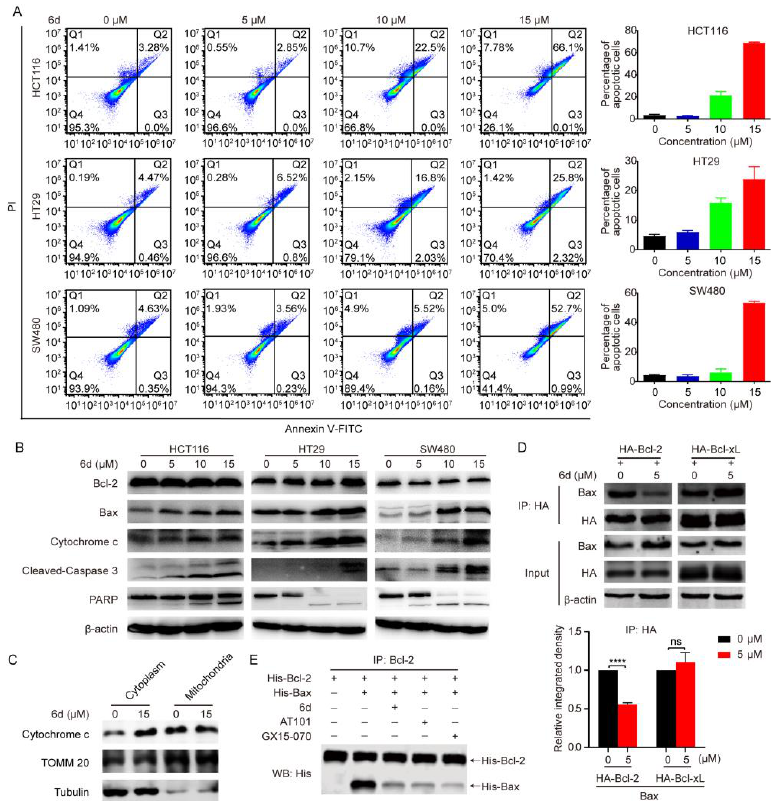
Figure 2. Compound 6d induces mitochondrial-mediated intrinsic apoptosis by targeting Bcl-2. ( A ) CRC cells were treated with indicated concentrations of compound 6d for 8 h and then stained with the Annexin V-FITC/PI kit. The stained cells were analyzed with flow cytometry analysis. ( B ) Compound 6d regulates the expression of apoptosis-related proteins. CRC cells were treated with different concentrations of compound 6d (0, 5, 10, 15 μmol/L) for 8 h. The release of cytosol cytochrome c, expression of the BCL2 family proteins Bcl-2 and Bax, the cleavage levels of activated caspase 3 and poly (ADP-ribose) polymerase (PARP), were estimated to determine whether or not the intrinsic apoptotic pathway is involved in the anti-tumor effect. β-actin level was used as internal control for equal protein loading. ( C ) Compound 6d treatment increased cytosolic cytochrome c levels. Control and compound 6d (15 μM)-treated cells were subjected to cell fractionation using kit to separate cytoplasmic and mitochondrial fraction, and then cytosolic and mitochondrial cytochrome c levels were detected through western blotting, respectively. The translocase of outer mitochondrial membrane 20 homolog (Tomm 20) was used as a mitochondrial marker. ( D ) Compound 6d inhibits the interaction between exogenous Bcl-2 and endogenous Bax, but not the interaction of Bcl-xL and Bax. After treatment, lysates from HCT116 cells transfected with HA-Bcl-2 or HA-Bcl-xL were pulled down with anti-HA, followed by WB with corresponding primary antibodies. **** p < 0.0001 versus vehicle. ( E ) In vitro binding assay was performed using recombinant His-Bcl-2 and His-Bax proteins. Anti-Bcl-2 antibody was used for pull-down after incubating recombinant proteins with compound 6d , AT101 and GX15-070, and then anti-His antibody was employed for WB. Both AT101 and GX15-070 were used as positive control.